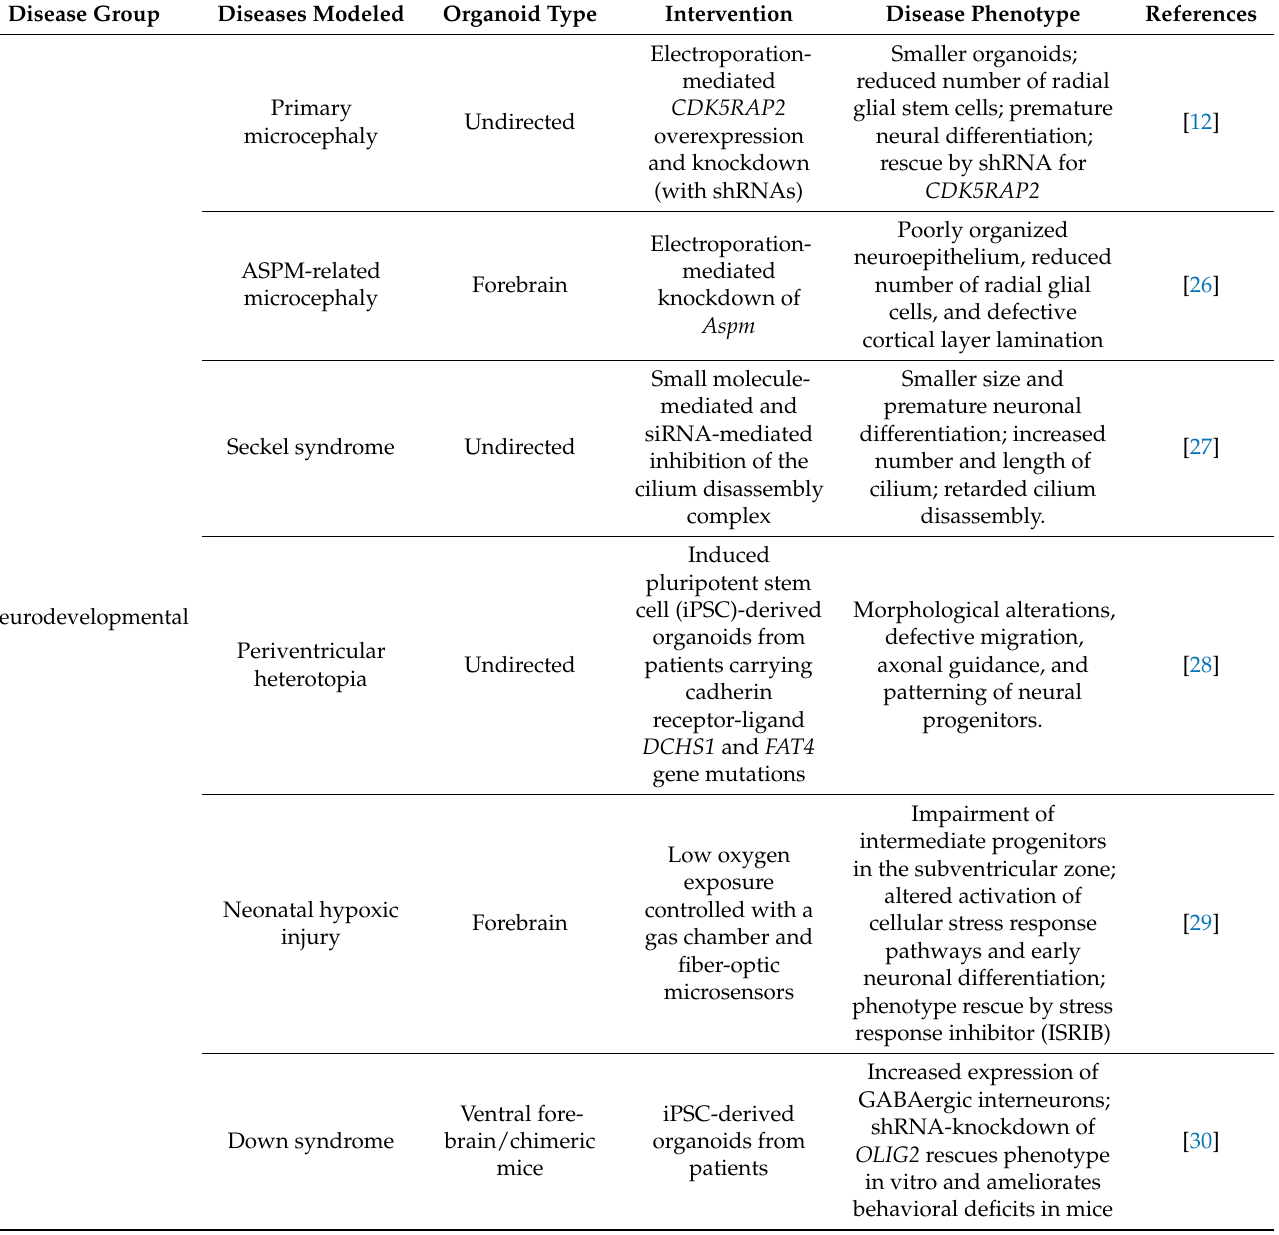
Table 1. Selected studies using neural organoids to model neurological diseases. Disease Group Diseases